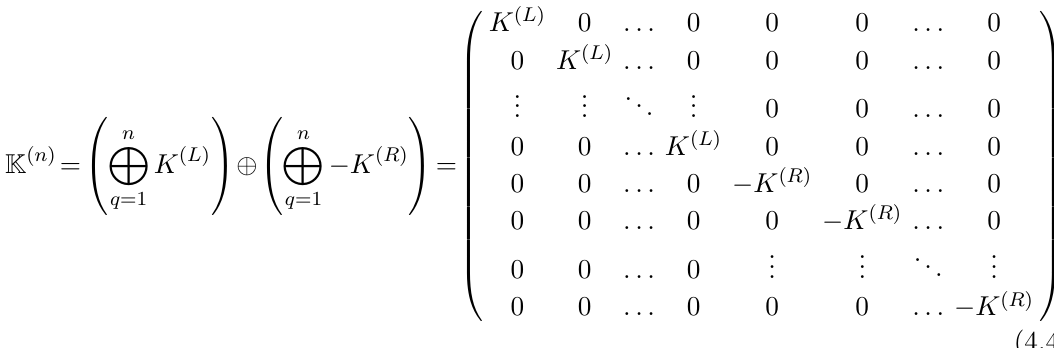
1 (cid:2) H 2 and then (cid:2) (cid:6)